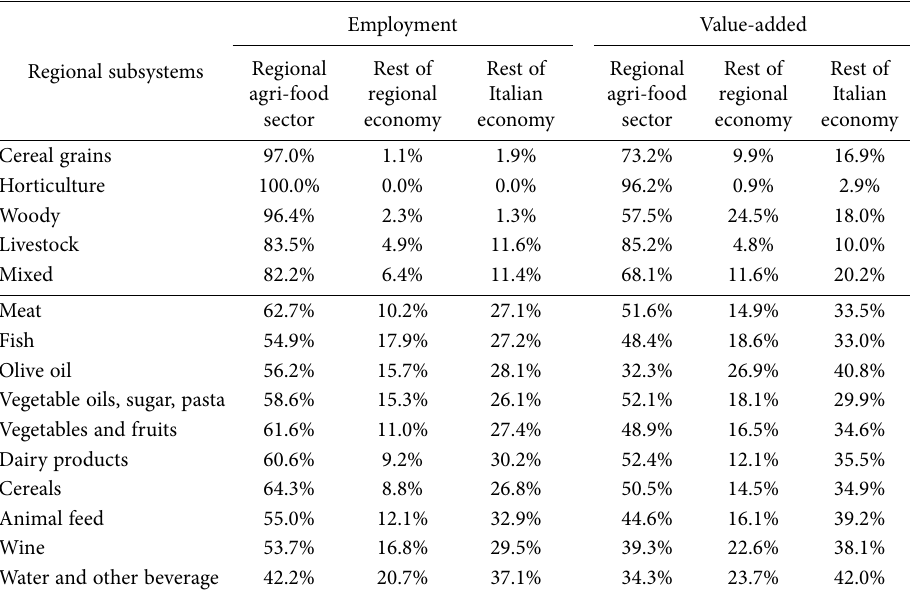
Table 7. Subsystem composition: sectors of Basilicata’s agri-food